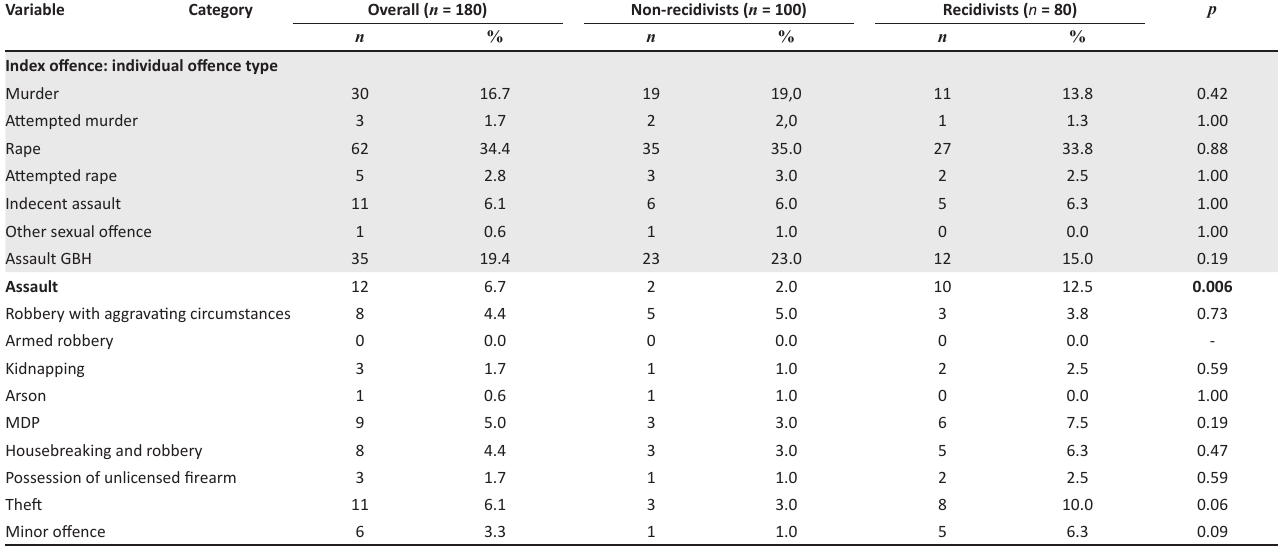
TABLE 2: Criminal variables – Comparison between recidivists and non-recidivists. Variable